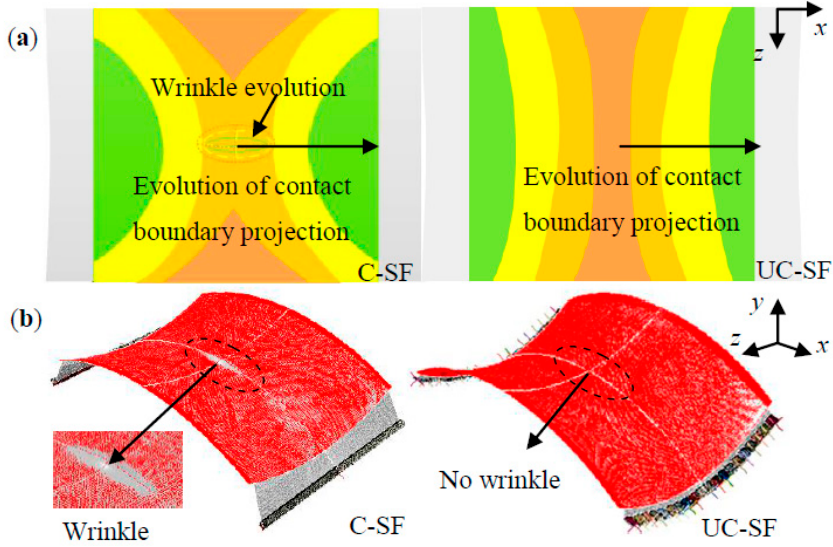
Figure 11. Contact state for saddle-shaped part. ( a ) Contact state evolution; ( b ) final contact